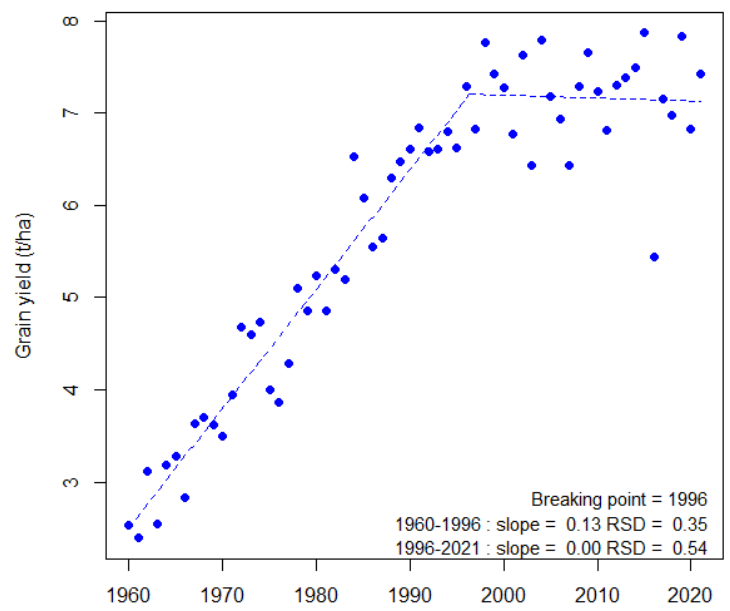
Figure 1. Evolution of bread wheat grain yield from 1960 to 2021 in France. A bi-linear regression model was fitted (blue dotted line) for grain yield using the segmented R package [7] with default settings. The value of the breaking point and the values of slope and standard deviation of the residuals (RSD) are indicated for each period. Data were from the Agreste database (https://agreste. agriculture.gouv.fr/agreste-web/accueil/ (accessed on 31 October